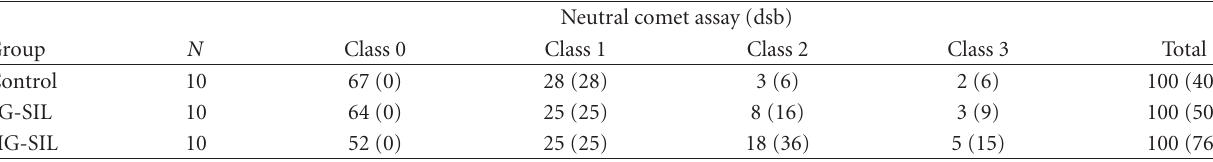
Table 3: Distribution of percentage of DNA damage evaluated in neutral conditions (dsb) in control, LG-SIL, and HG-SIL women.